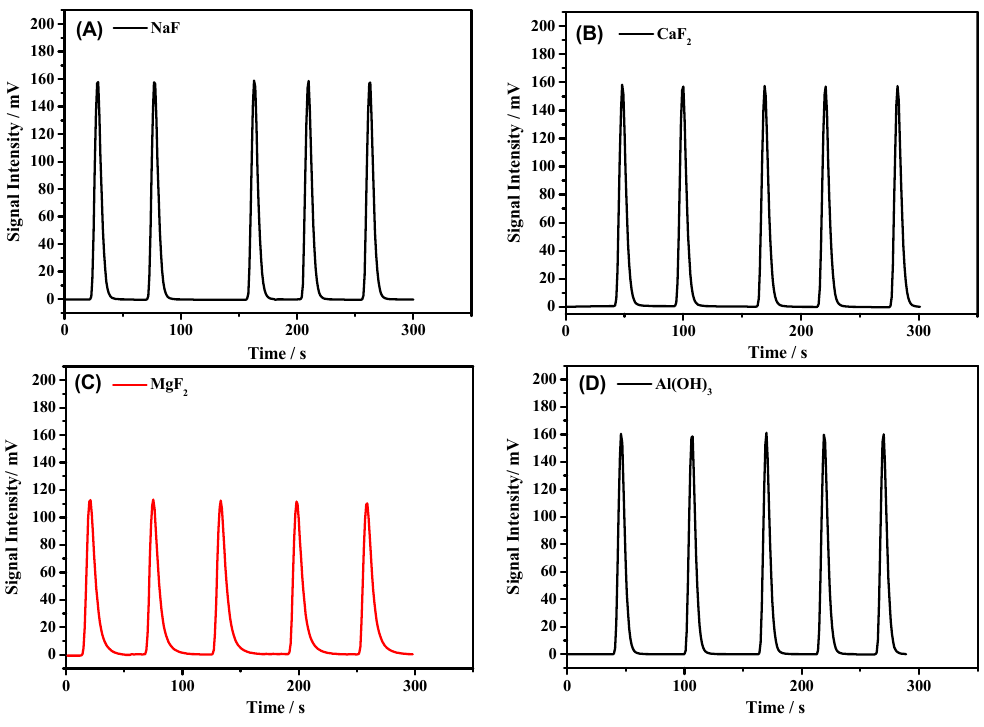
Figure 4. Adsorption performance of HF adsorbents on C 4 F 7 N , ( A ) NaF, ( B ) CaF 2 , ( C ) MgF 2 , ( D ) Al(OH) 3 .